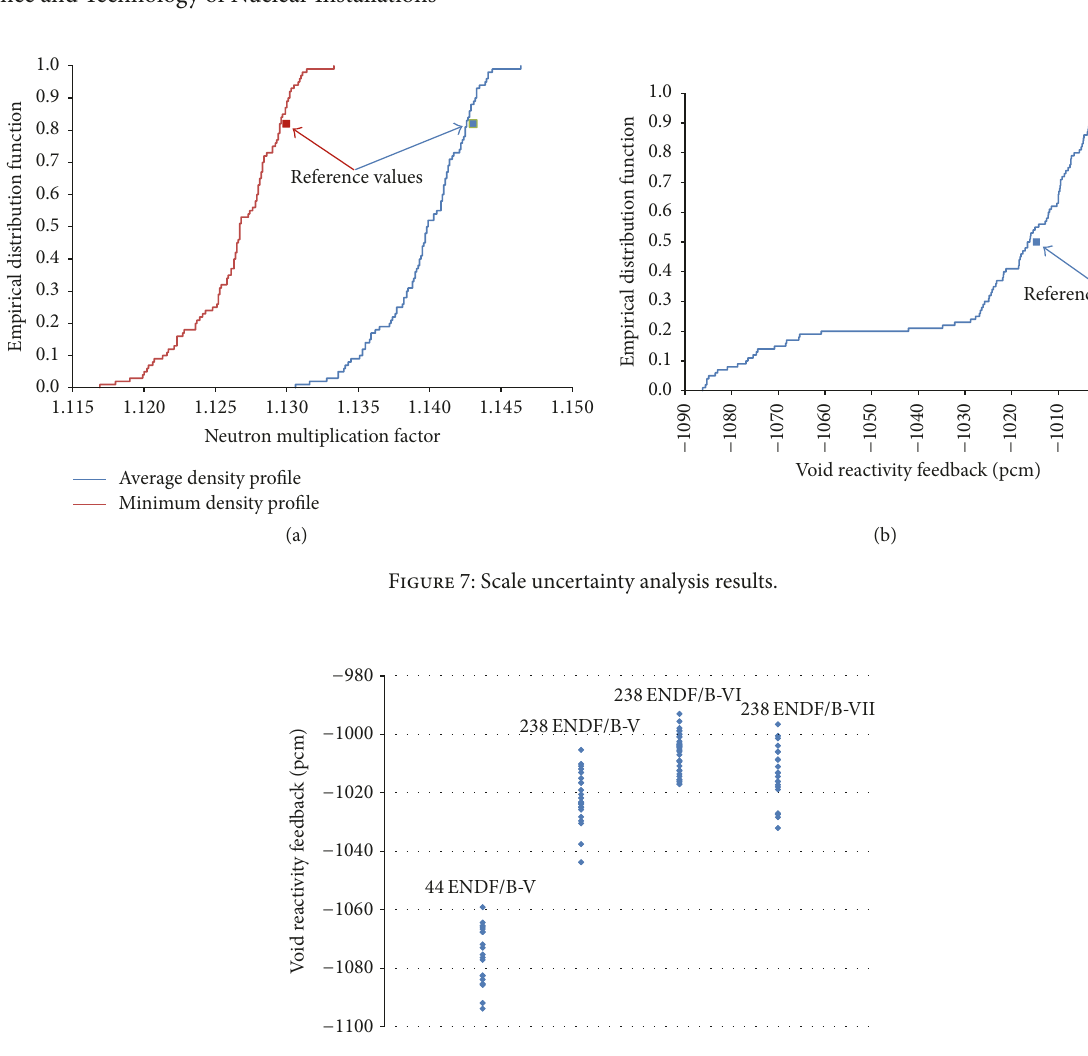
Figure 8: The correlation between the cross section library and void reactivity